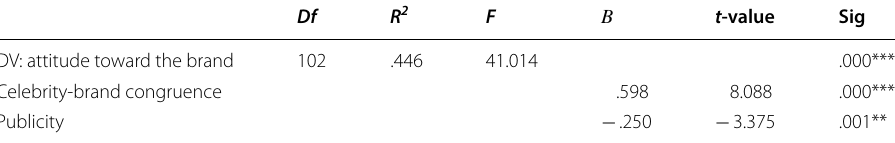
DV dependent variable